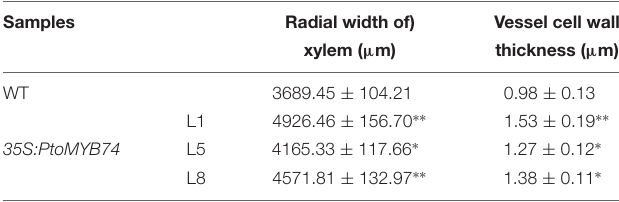
TABLE 1 | Radial width of xylem and cell wall thickness of vessels in stems of WT and PtoMYB74 transgenic poplar plants. Samples Radial width